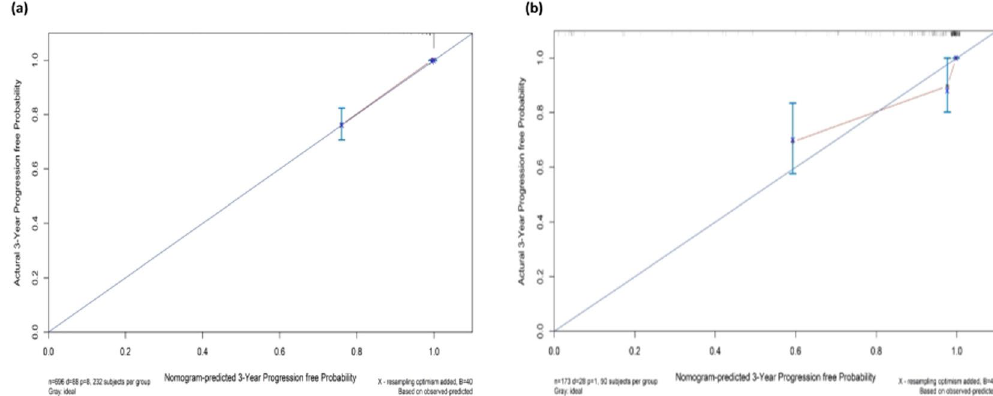
Figure 2. The calibration curves of the nomogram for predicting the 3-year prognosis of IgAN patients in the development cohort ( a ) and validation cohort ( b ). The X-axis represents the nomogram-predicted probability of progression, and the Y-axis represents the actual probability estimated with the Kaplan-Meier method. The blue line represents the ideal correlation between nomogram-predicted and actual probability.